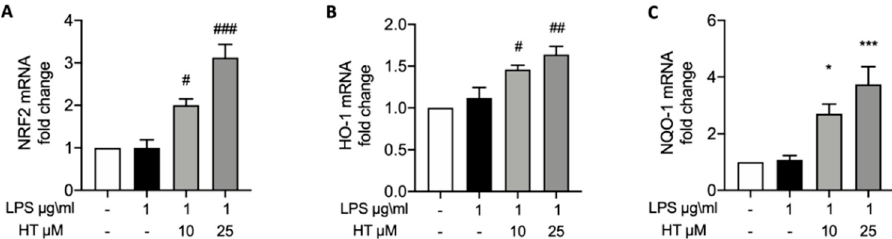
Figure 1. HT pre-treatment on LPS-induced Nrf2 pathway in BEND cell: mRNA levels of Nrf2 ( A ), HO-1 ( B ) and NQO-1 ( C ). * p < 0.05 vs control; # p < 0.05 vs. LPS; ## p < 0.01 vs. LPS; *** p < 0.001 vs. control; ### p < 0.001 vs. LPS.